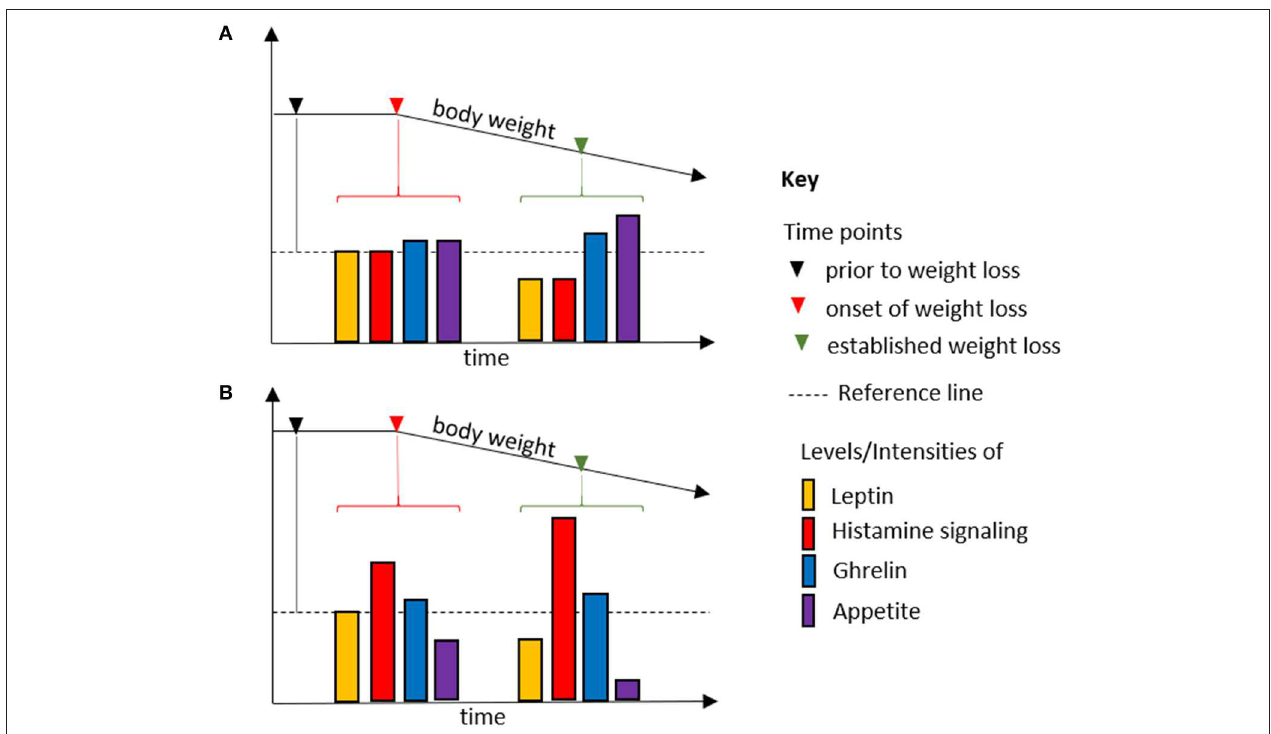
FIGURE 1 | Body weight loss due to fasting (A) and in cancer cachexia (B) . Histamine signaling is downstream and an integral part of the anorexigenic effect of leptin. As an adiposity sensor, leptin plasma levels, and thus histamine signaling, mirror the course of weight loss during fasting and in cancer cachexia. Analogously, average ghrelin levels are increased in (A,B) . However, whereas histamine signaling is determined by leptin levels in fasting, it is uncoupled from it in cancer cachexia. Thus, relative levels of leptin and ghrelin promote appetite in fasting, but not in cancer cachexia. Increased histamine signaling overrules the hormonal regulatory mechanisms in food intake, allowing anorexia to be established as the default